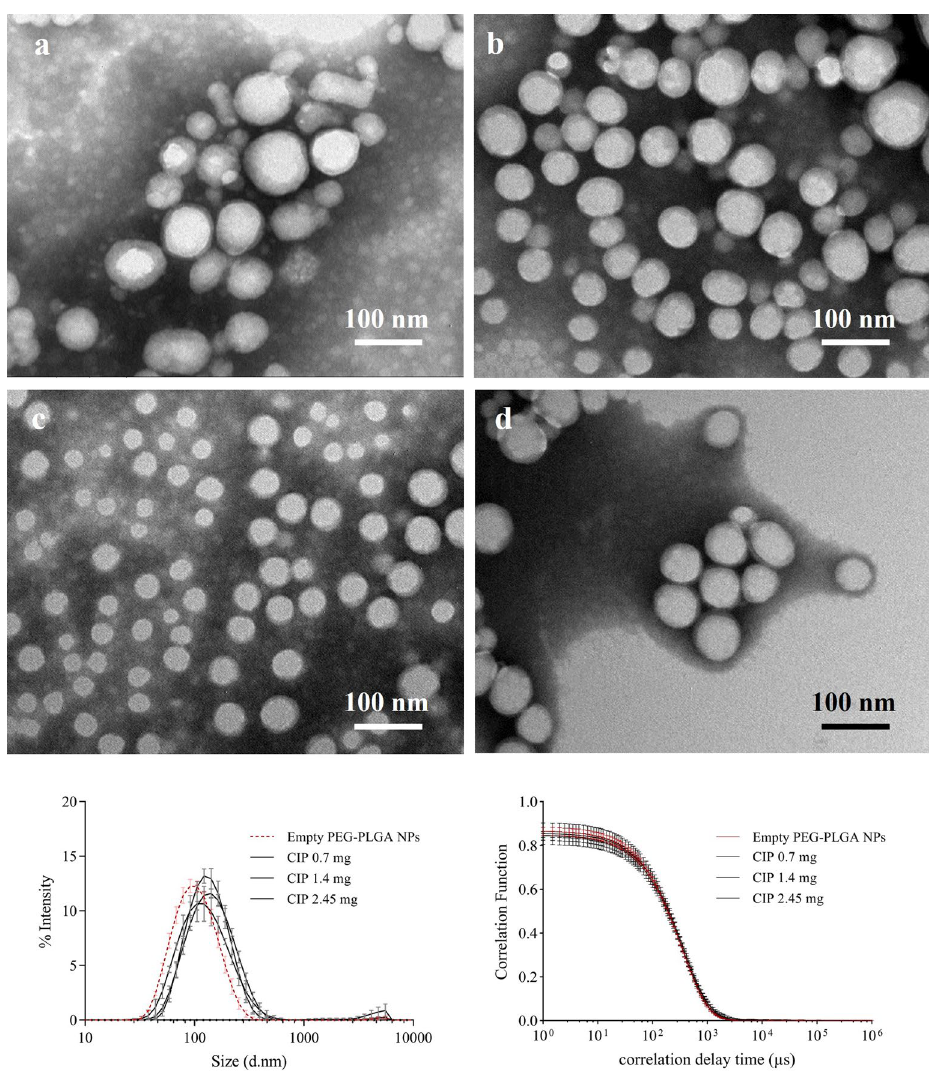
Figure 1. Electron micrographs of the empty PEG–PLGA NPs ( a ), CIP-loaded PEG–PLGA NPs at CIP initial weight of 0.7 mg ( b ), 1.40 mg ( c ), and 2.45 mg ( d ) observed by TEM. The images were taken at 40,000 × magnification. The plots represent the size distribution by the intensity and correlation function of the samples, the error bars in the plots refer to the standard deviation (s.d.) obtained from three independent experiments .